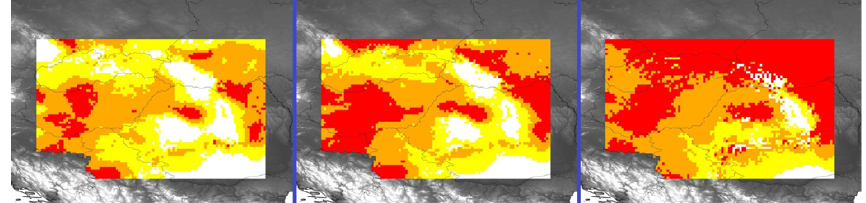
Figure 3. Left to right: drought maps of SPI-3, SPEI-3, and RDI-3 related to February 1990. See Table 2 for colour-scale.